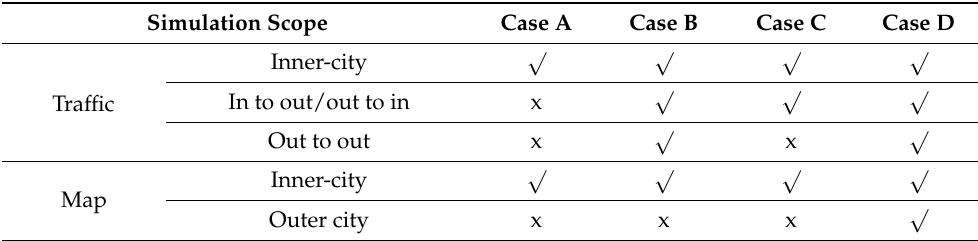
Table 1. Comparison of different